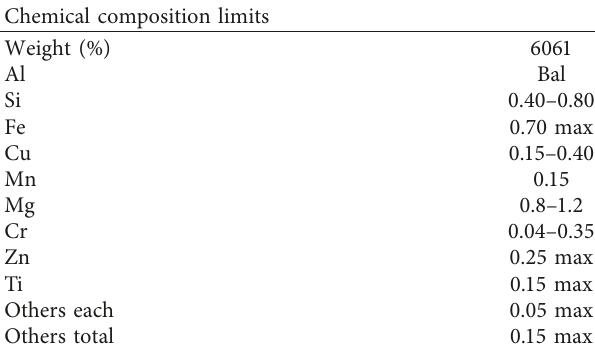
Table 2: Chemical composition of A6061.